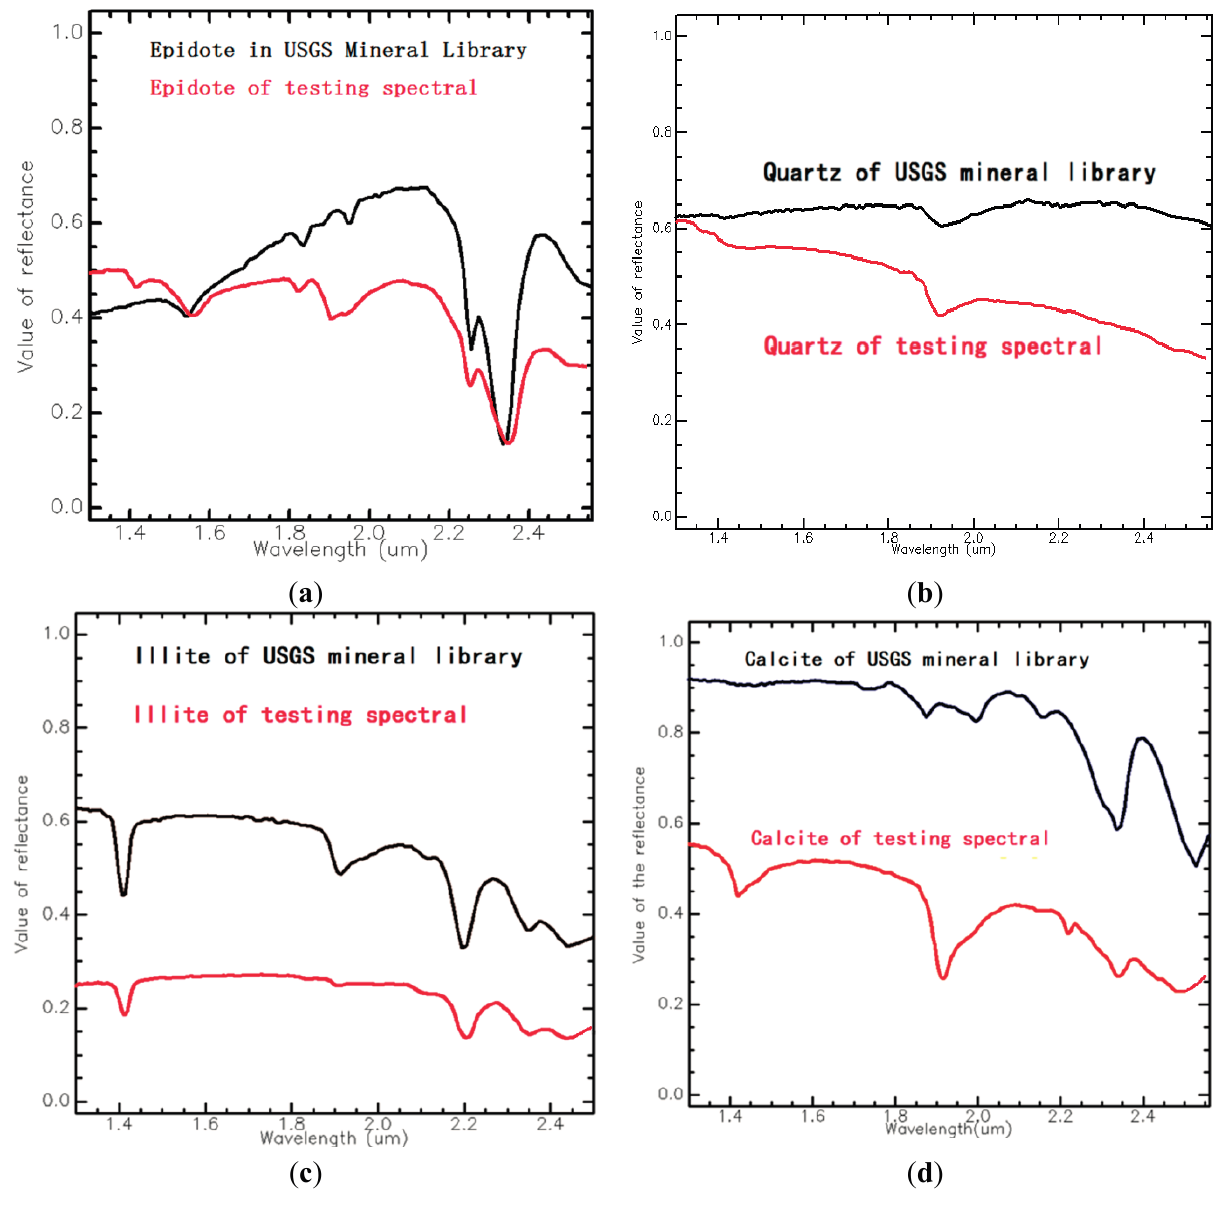
Figure 10. Comparative analysis between the spectra of the main minerals identified in